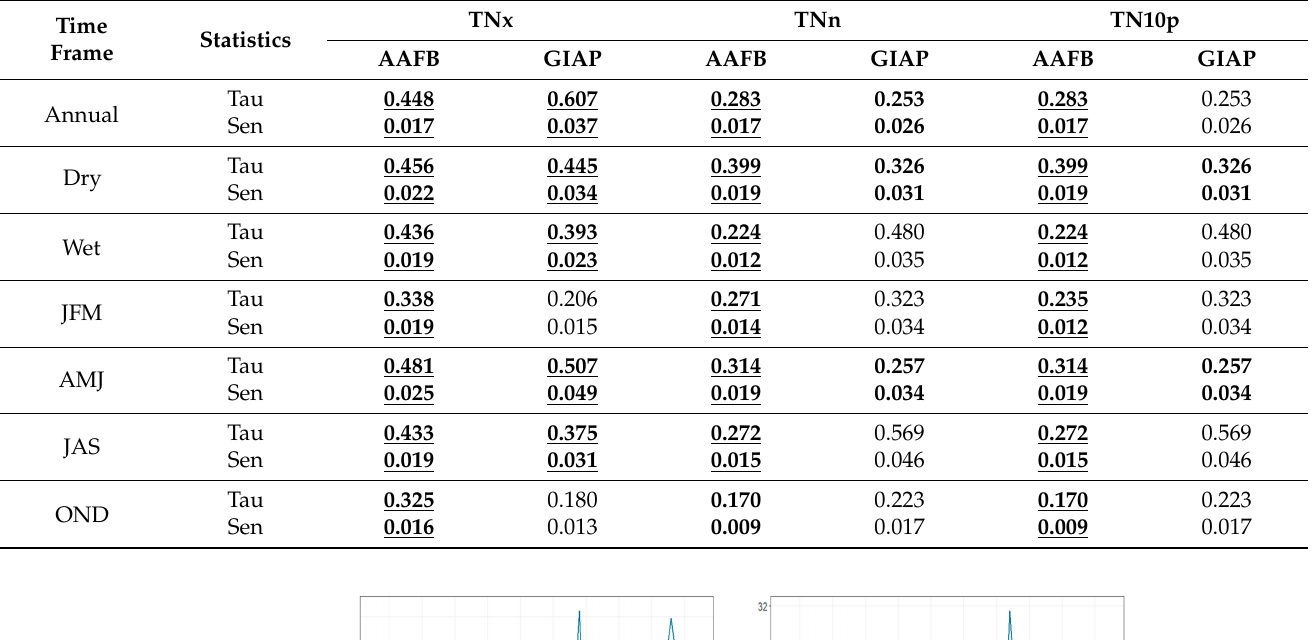
Table 4. Mann–Kendall’s tau and Sen’s slope ( ◦ C/year) for annual/two-seasonal/four-seasonal maximum of Tmin, minimum of Tmin, the 10th percentile of Tmin from two stations (Andersen Airforce Base and Guam International Airport). Bold and underlined values represent statistically significant strong trend ( p ≤ 0.05), and those bold represent a significant trend (0.05 < p -value ≤ 0.1). Here, JFM denotes the season from January to March, AMJ does from April to June, JAS does from July to September, and OND does from October to December.